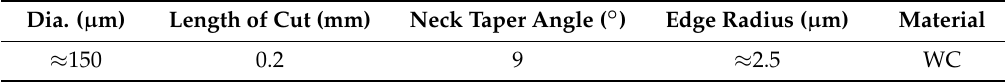
Table 2. Composition of Elgiloy (%).